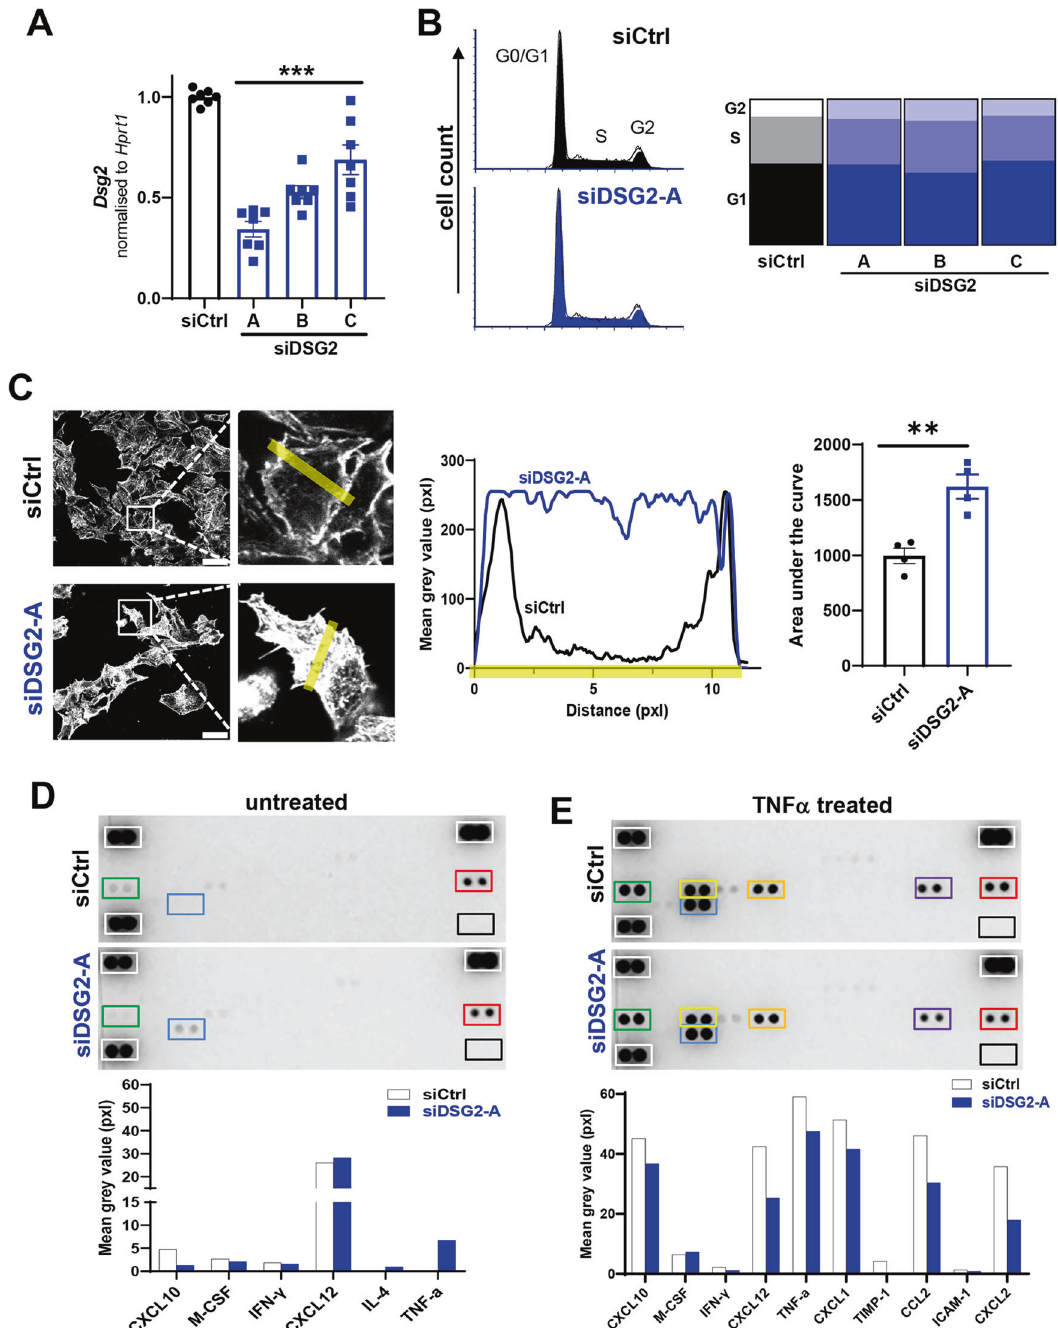
Fig. 7 Cell cycle distribution, F-actin regulation and cytokine production by Beta-TC-6 cells without and with Dsg2 knockdown. A Representative qRT-PCR showing Dsg2 gene expression for siCtrl (black) and siDSG2 (A-C, blue) groups normalised to housekeeper Hprt1 , n = 7 independent experiments, *** p < 0.001. B Cell cycle distribution (G0/G1, S or G2 phase) of Beta-TC-6 cells without (siCtrl, black) and with Dsg2 knockdown (siDSG2, blue) using fl ow cytometry PI staining, n = 3 independent experiments. C Representative immuno fl uorescence image of Phalloidin-labelled fi lamentous actin in Beta-TC-6 cells without (siCtrl, black) and with Dsg2 knockdown (siDSG2-A, blue). Yellow rectangle highlights the area of interest which was used to calculate the mean grey value (pixels) across the cell from border to border. The mean grey value for siCtrl (black) and siDSG2-A (blue) was converted to area under the curve (AUC), n = 4 independent experiments, ** p < 0.01. D Cytokine/chemokine array of supernatants harvested from Beta-TC-6 cells without (siCtrl) or with Dsg2 knockdown (siDSG2-A), n = 1 experiment. Mean grey value of duplicate dots was calculated and summarised as a bar graph below. White box = positive control, black box = negative control, green box = CXCL10, blue box = TNF-alpha, red box = CXCL12. E Cytokine/chemokine array of supernatants harvested from Beta-TC-6 cells without (siCtrl) or with Dsg2 knockdown (siDSG2-A) following TNF α treatment (100 ng/ml, 24 h), n = 1 experiment. For detectable proteins, mean grey value of duplicate dots was calculated and graphed. White box = positive control, black box = negative control, green box = CXCL10, yellow box = CXCL1, blue box = TNF α , orange box = CCL2, purple box = CXCL2, red box = CXCL12.